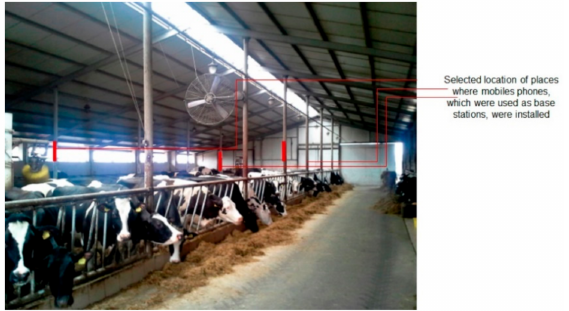
Figure 1. Selected locations of places where mobile phones were